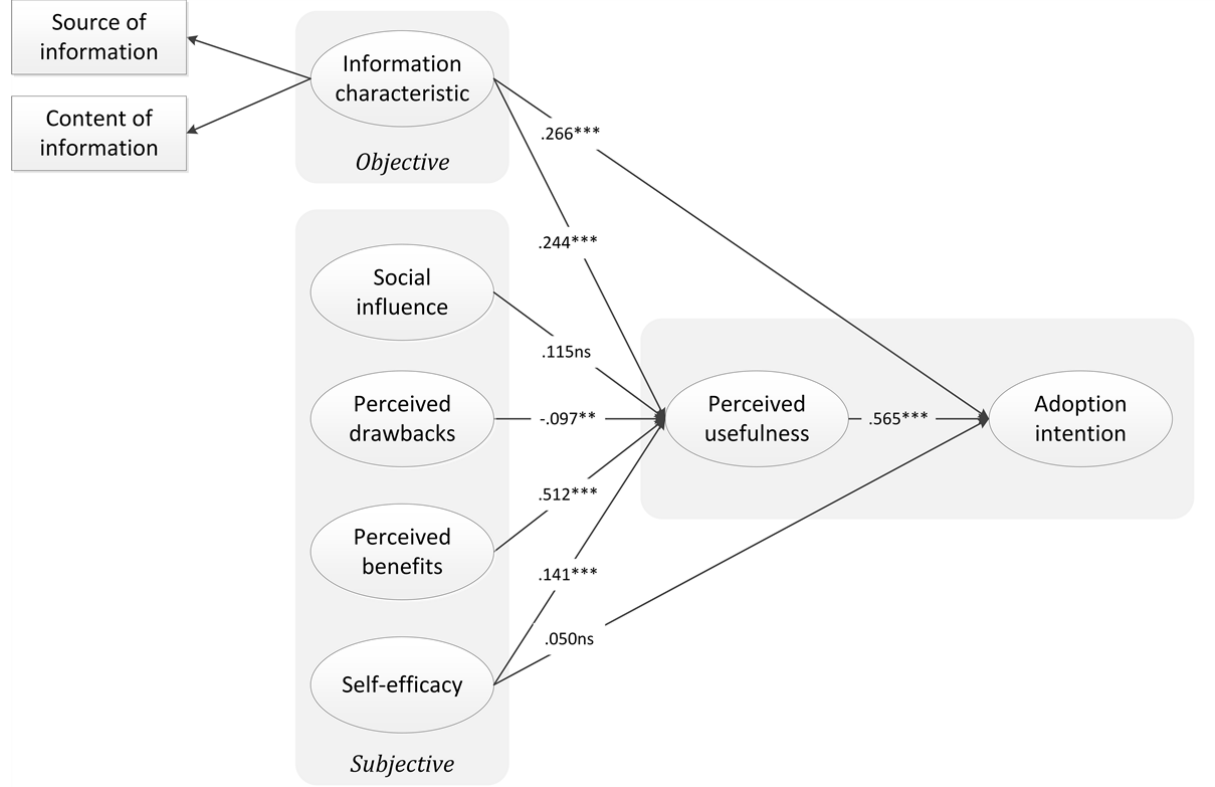
Figure 2. Structural model results; standardized path coefficients ( β ) are shown. *** P <.001; ** P <.01; ns: not significant ( P